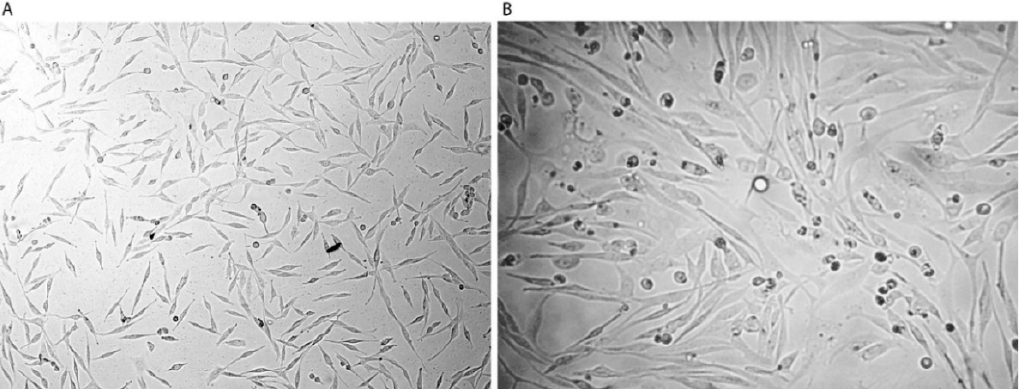
Figure 9. Morphology of U87-MG cells (U87-S) (100X magnification); ( A ) Before ( B ) After treatment with periodic exposure to temozolomide produces a chemo-resistant phenotype with longer extrusions and irregular shapes.